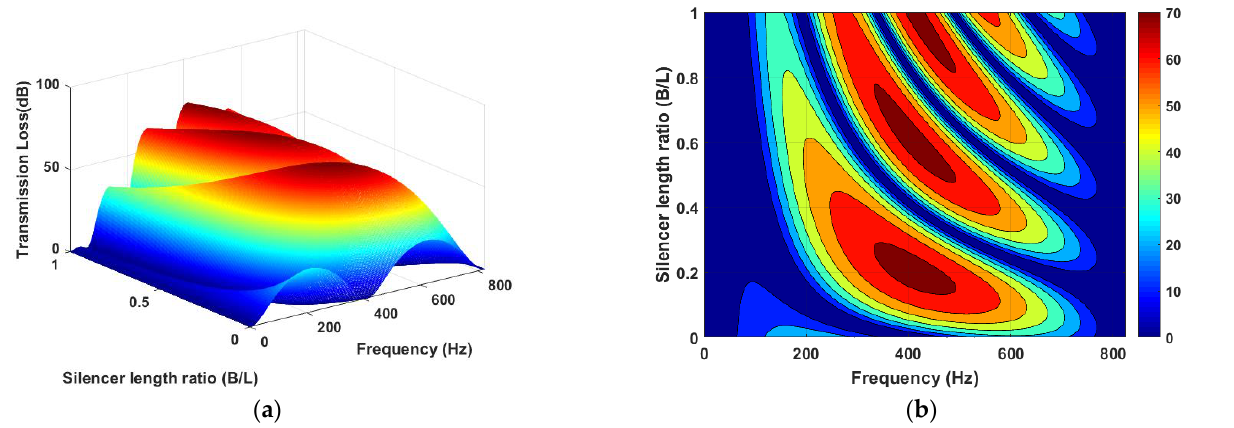
Figure 14. Modeled TL vs. S/C ratio (B/L) and full periodicity of frequency ( a ) 3D plot and ( b ) contour plot.